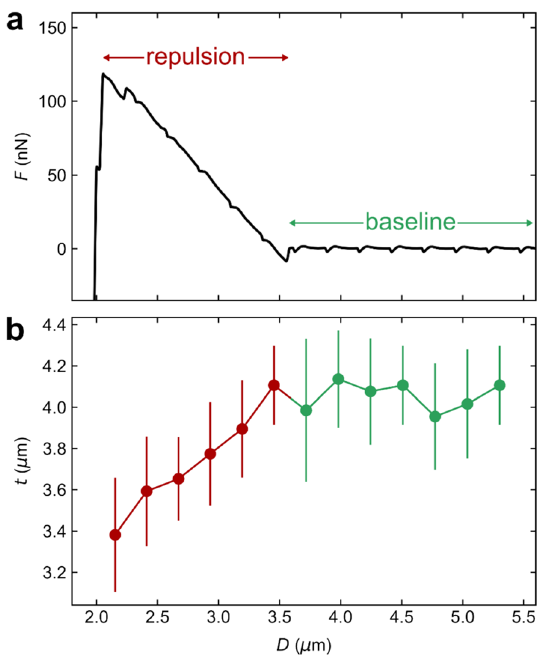
Figure 4. Example of a measurement in hexadecane where a measured repulsive force ( F ) is observed on approach with the corresponding gaseous layer thicknesses ( t ): ( a ) F as a function of separation D zoomed-in on the repulsive part, ( b ) t observed directly underneath the particle at the corresponding separation. The error bars show the standard deviation at each point. The piezo expansion rate was 0.2 µm s −1